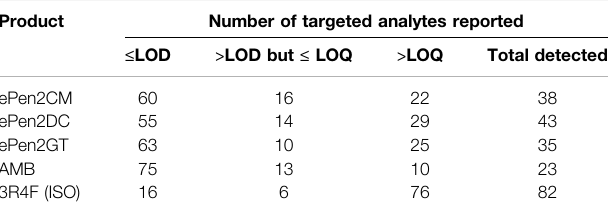
TABLE 2 | Numbers ofthe 98 targeted analytesundetected ( ≤ LOD), detected but not quanti fi ed ( > LOD but ≤ LOQ) and quanti fi ed ( > LOQ) in the test articles and AMB.